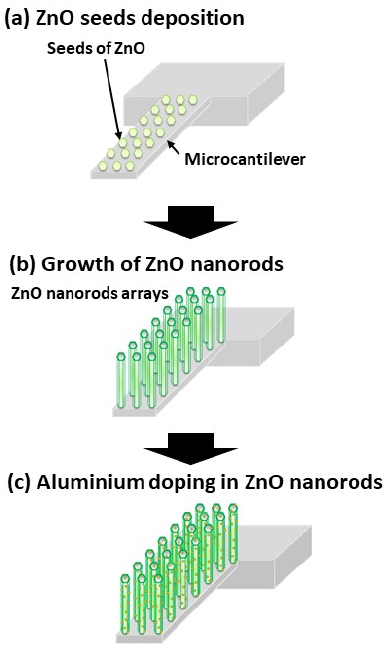
Figure 1. Growth process of Al-doped ZnO nanorods on microcantilever consisting of ( a ) ZnO seeds deposition; ( b ) the growth of ZnO nanorods; ( c ) Al doping in ZnO nanorods using RF sputtering.